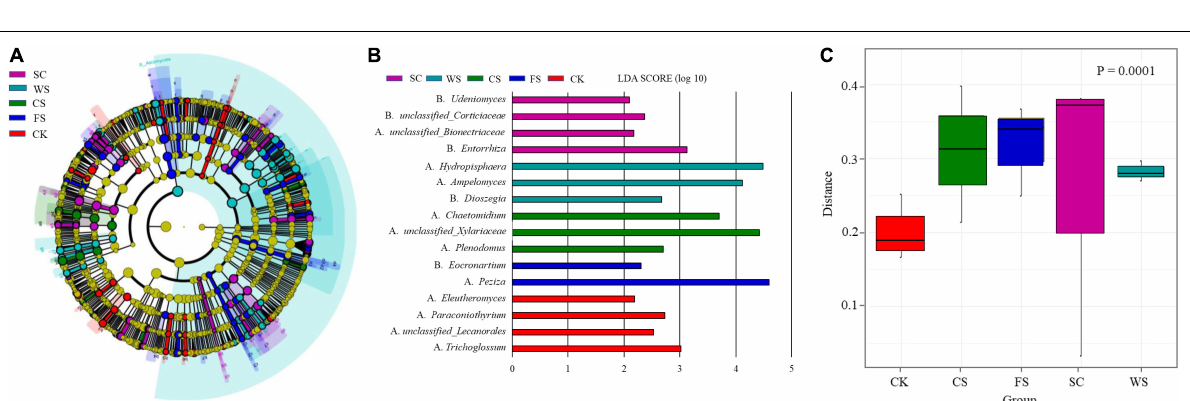
FIGURE 3 | Relative abundance of different fungi at the phylum level (A) and heatmap analysis (B) of the dominant fungal genera with relative abundance greater than 0.5% in five soybean cropping systems. The color code indicates relative abundance, ranging from white (low abundance) to blue (high abundance).